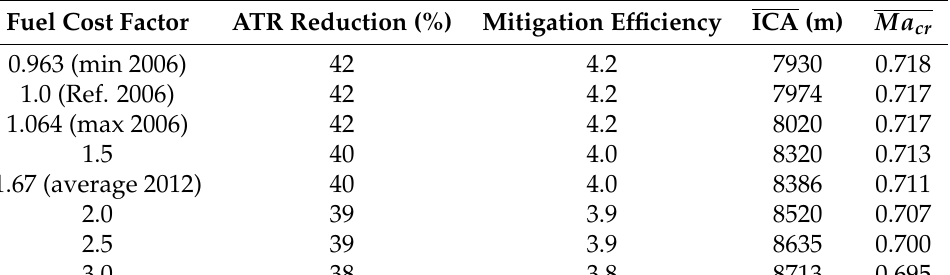
Table 8. Mitigation potentials and efficiencies at COC rel , all = 1.1 with corresponding average cruise conditions (ICA, Ma cr ) for selected fuel price factors.